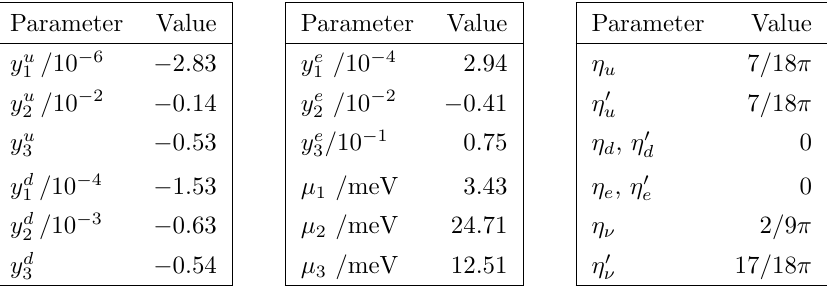
Table 5 . Model parameters to generate the (cid:12)t in table 2 with